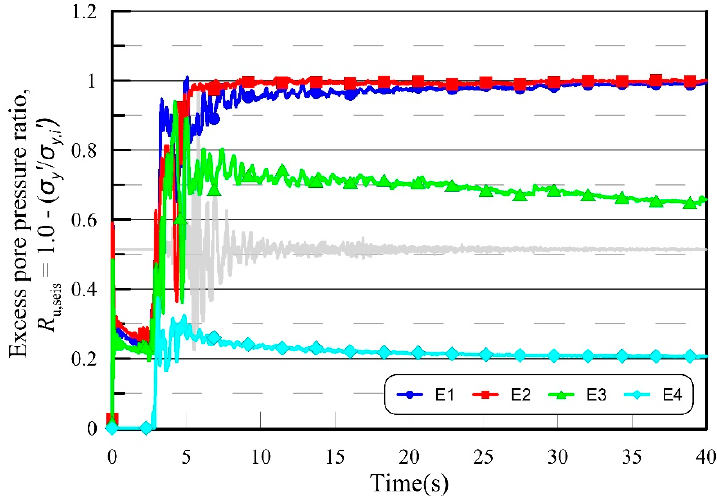
Figure 19. Excess pore pressure ratio generated during shaking ( R u,seis ).